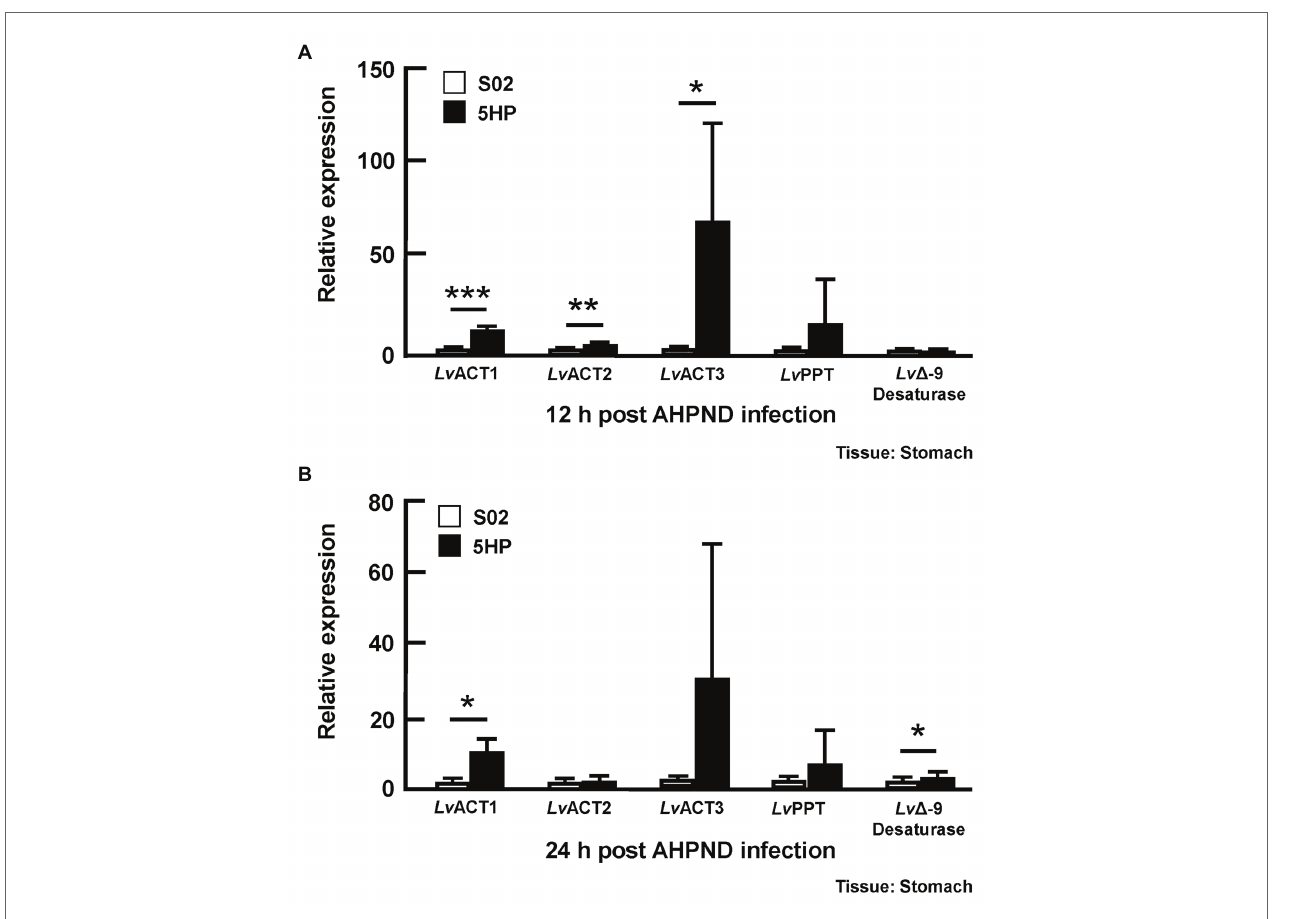
FIGURE 4 | Acute hepatopancreatic necrosis disease infection affected the expression of genes related to the biosynthesis of unsaturated fatty acids. Stomach samples of 5HP-challenged and S02-challenged shrimps were collected at (A) 12 and (B) 24 hpi were analyzed for expression of genes involved in the biosynthesis of unsaturated fatty acids ( Lv ACT: Acyl-coenzyme A thioesterase, Lv PPT: Palmitoyl-protein thioesterase, LvΔ -9 Desaturase). Graphs represent mean ± SD. Differences between treatment groups are indicated by asterisks (Student’s t -test, * p < 0.05, ** p < 0.01, and *** p <